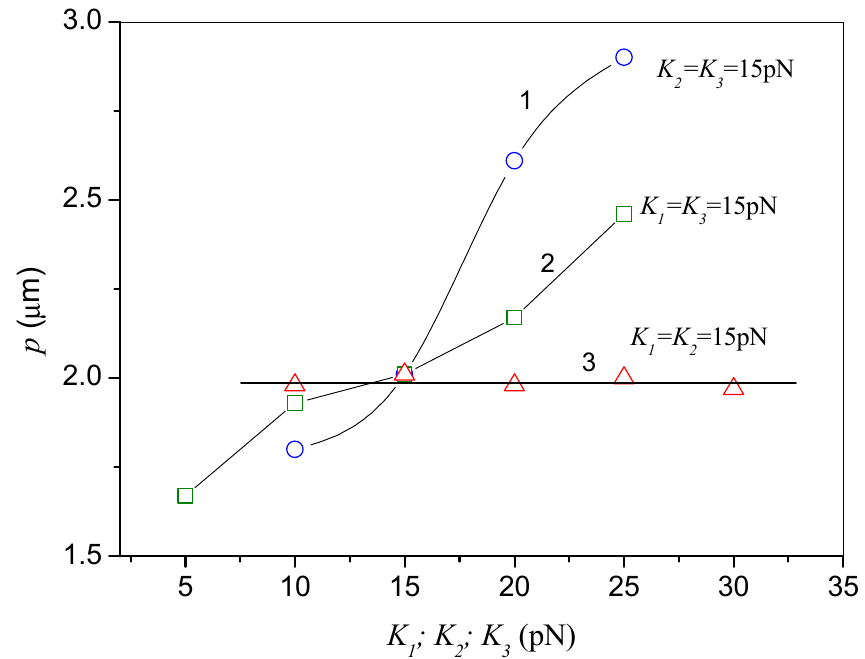
Figure 5. Dependence of the spatial period p on one of the three elastic coefficients at fixed and equal values of the other two elastic coefficients for U = 13V.